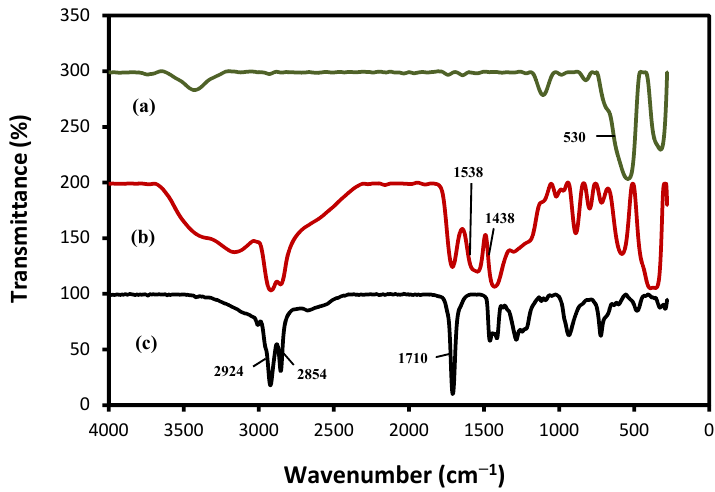
O , ( b ) Fe O /OA, and ( c ) pure 3 4 3 4